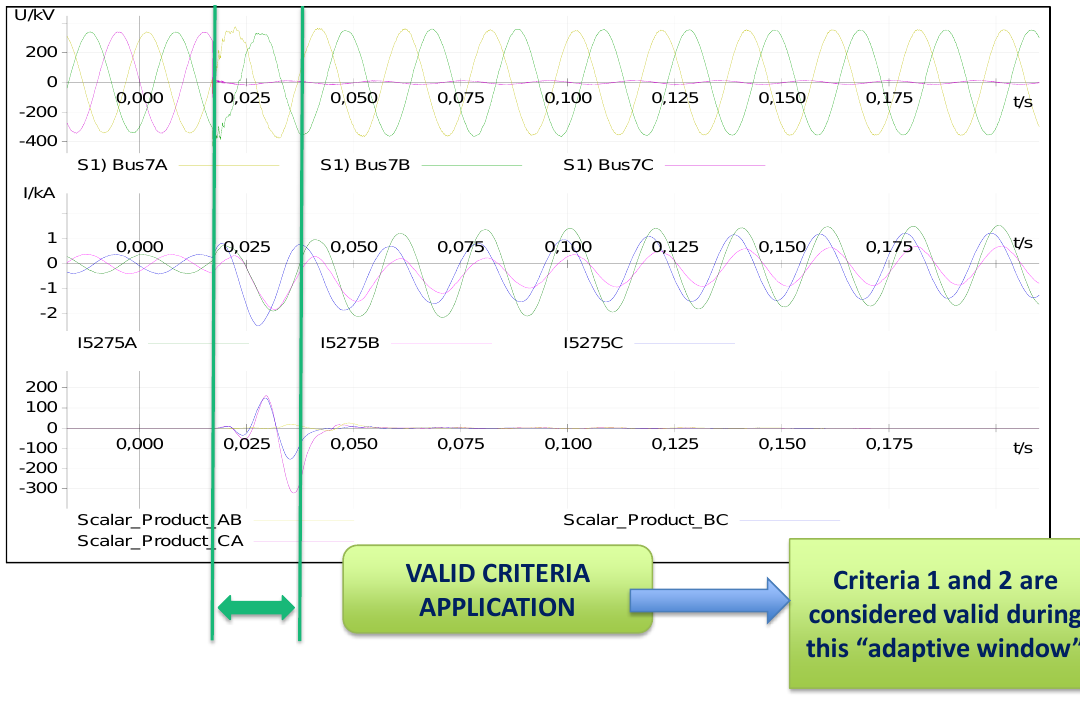
Figure 13. Adaptive window for a SLG fault.